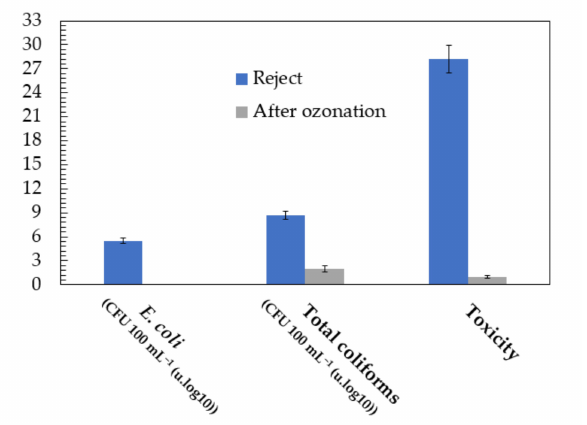
Figure 4. Reduction in toxicity and pathogenic microorganisms averaged over the 4 days analysed by applying an ozonation treatment. Experimental conditions: F G = 1.6 mg min − 1 , P = 1.5 bar, C O = 6.4 mg L − 1 , pH 0 = 9.0, T = 15.0 ◦ C and V = 30.0 3